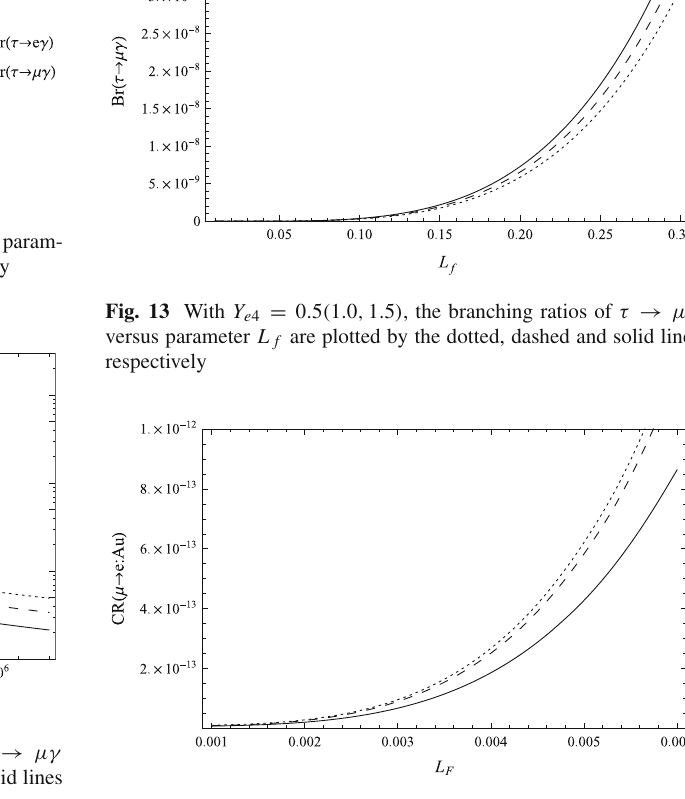
Fig. 14 With tan β NL = 1 . 8 , 2 . 2 , 2 . 6, the μ − e conversion rates in Au nuclei versus parameter L F are plotted by the dotted, dashed and solid lines